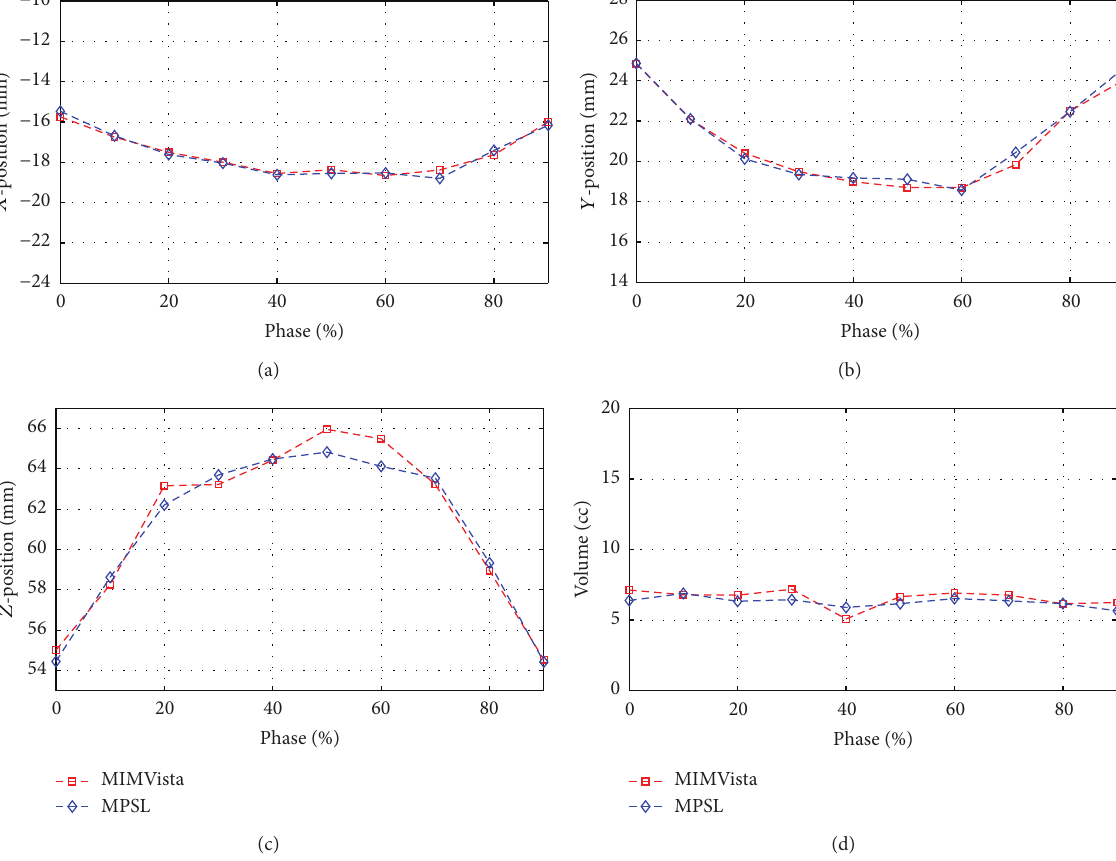
Figure 7: Good agreement of MPSL based estimation of GTV position and volume quantification with MIMVista based estimation for different phases of the 4DCT scan shown in a patient with 6cc